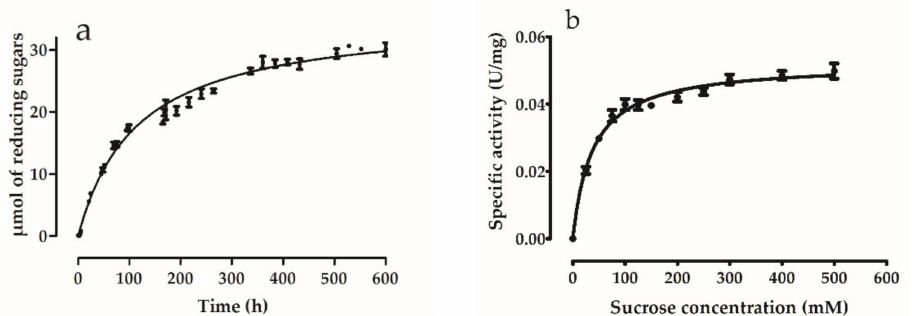
Figure 5. Activity of Hmc Isc assessed ( a ) temporally by following µ mol of released reducing sugars, and ( b ) at increasing sucrose concentrations. Error bars represent standard error values for three replicates. µ mol concentrations of released reducing sugars were followed with 150 mM initial sucrose concentration. Activity of Hmc Isc assessed at increasing sucrose concentrations was measured during 24 h reaction time. Optimal pH, temperature and salt (NaCl) concentration were selected as 7.0, 45 ◦ C and 3.5 M, respectively for the determination of enzyme